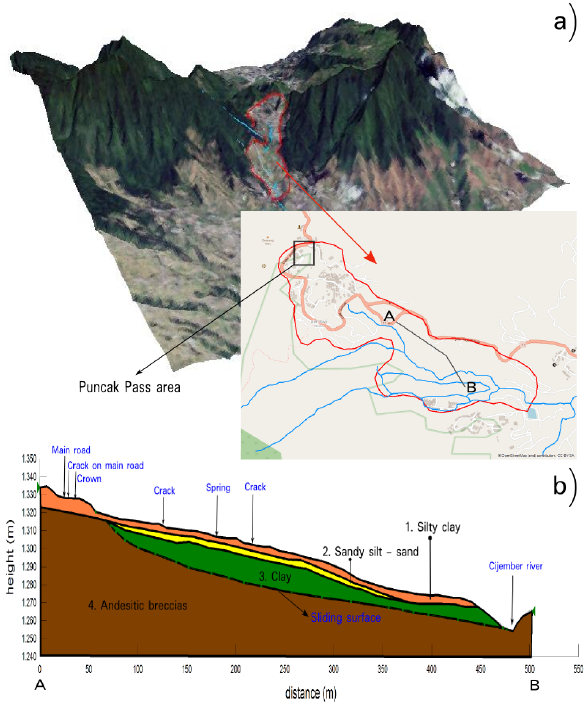
Figure 1. a) The study area is located in the Ciloto District, West Java, Indonesia. The 3D map describes the hilly area along the CiJember river flowing in the middle of it. b) The drilling profile based on line A-B in Fig